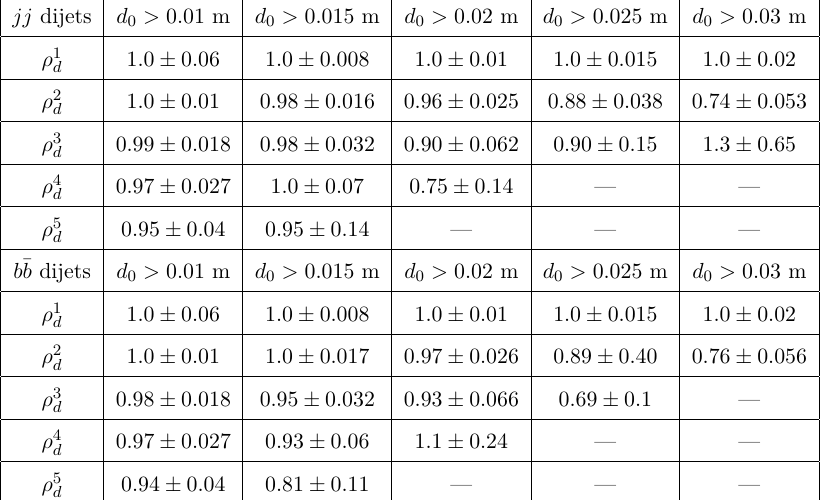
— — — Table 6 . The correlation table for multiple d 0 tracks for QCD dijet backgrounds without applying the vertexing-cuts . The symbol “—” means no events left and the number in “( )” indicates the small number of statistics after the cuts. When increasing to multiple tracks and larger d 0 cuts, there are less events thus the result suffers from larger statistical fluctuations. It is an auxiliary check for table 2 that is after applying the vertexing-cuts